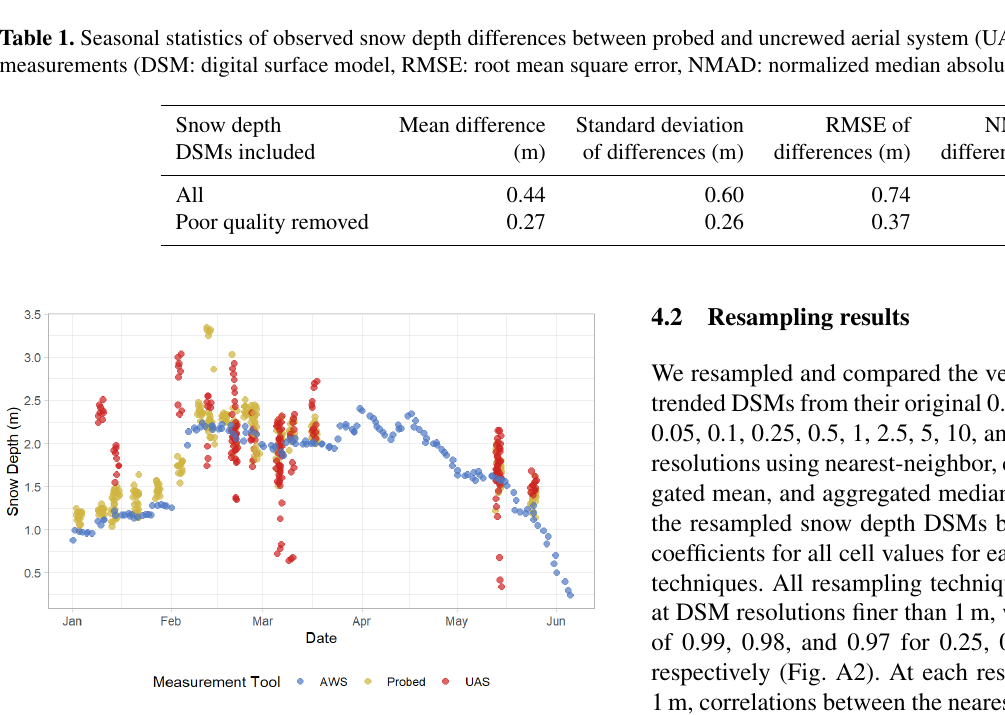
Figure 2. Measured snow depths (m) from 1 January–5 June 2020, including additional in situ probed measurement days where un- crewed aerial system (UAS) models were discarded due to poor sur- face reconstruction. The Brackett meadow automated weather sta- tion (AWS, blue) represents the sonic rangefinder-measured snow depth. Probed (yellow) snow depths are collected manually in situ as validation points. UAS (red) snow depths are derived from dig- ital surface model (DSM) differencing at each validation point on a given observation day. Probed points represent snow depth mea- surements from within the meadow and low relief and lower eleva- tion portions of the Hourglass and do not represent the same loca- tion as the sonic rangefinder attached to the Brackett meadow